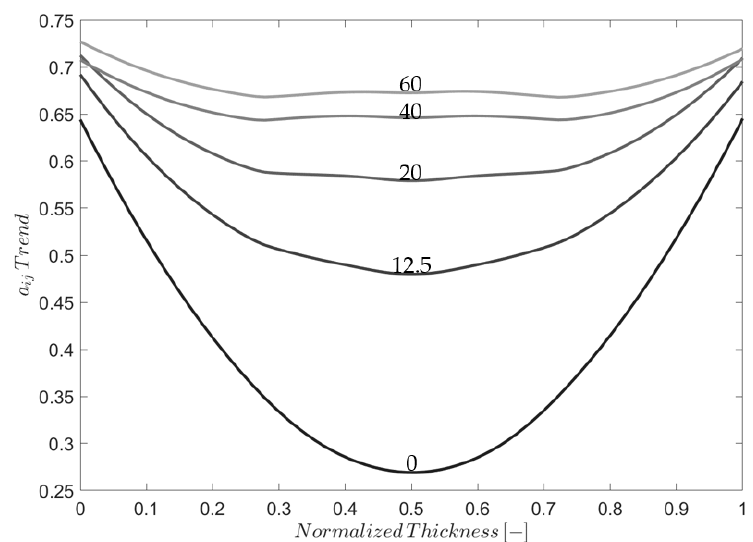
Figure 14. Smoothed computational a11 evolution of compression molded samples [43].